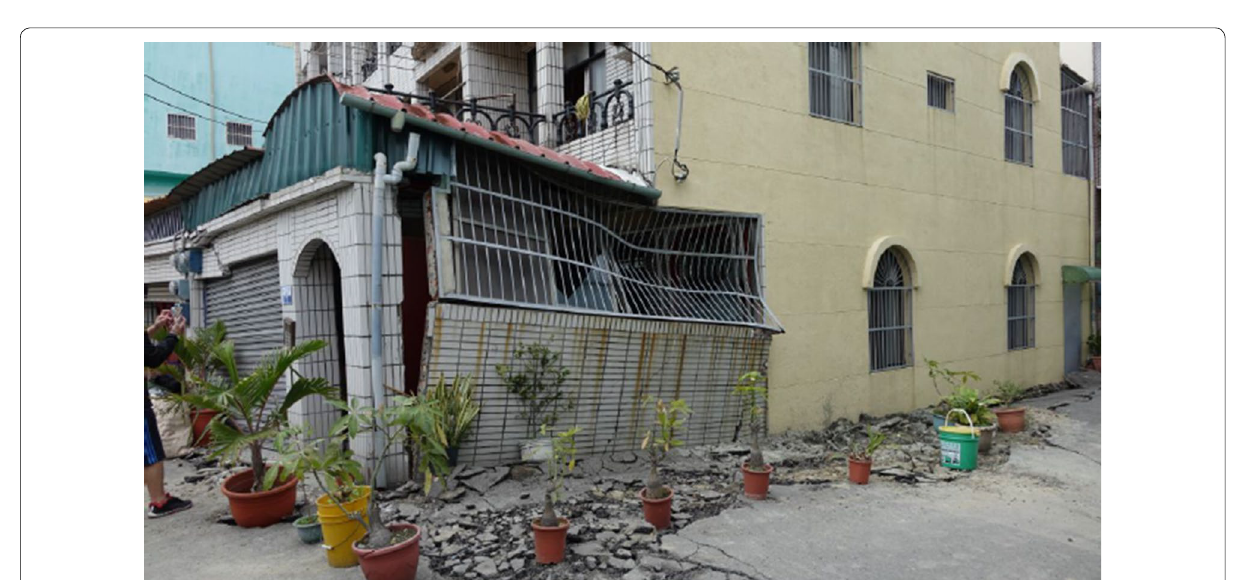
Fig. 4 Damage to No. 7 building at Alley 10, Lane 50, Sanmin Street (Sinshih